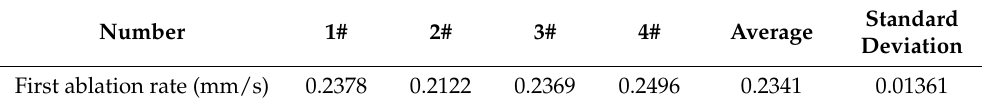
Table 3. The ablation rate after experiments.